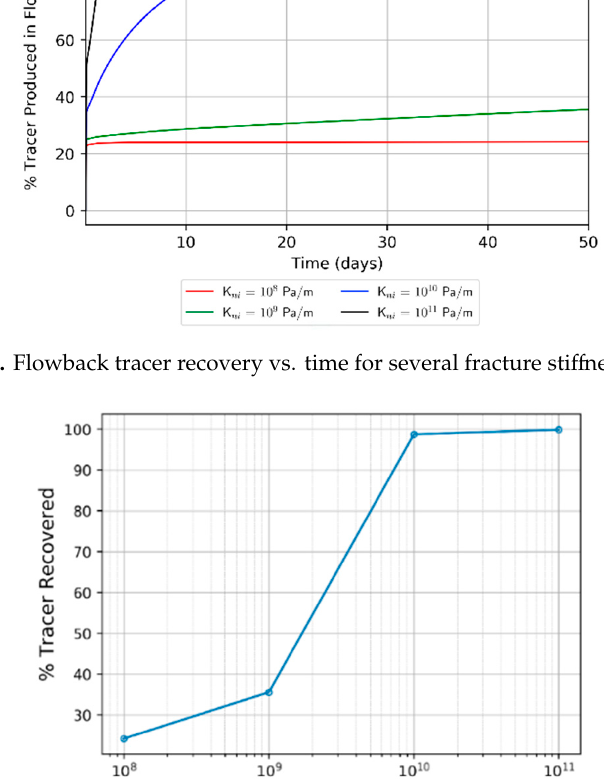
Figure 13. Percentage tracer recovered decreases with a decrease in the fracture stiffness. At lower fracture stiffness, fracture closure is faster, and this leads to tracer retention in the fracture and the reservoir.